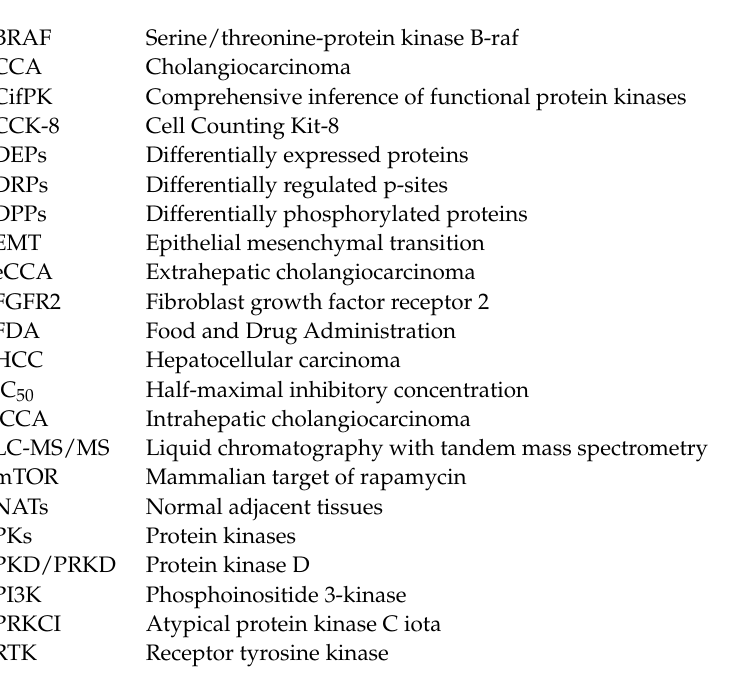
Figure S5: The CCK-8 assay of PK candidates. Figure S6: The heatmap of the amino acid profile of the serine-phosphosites and threonine-phosphosites. Table S1: Characteristics for patients. Table S2: TMT labeling data. Table S3: The proteomic and phosphoproteomic profiling of CCAs. Table S4: List of siRNA. Table S5: List of predicted kinase from different